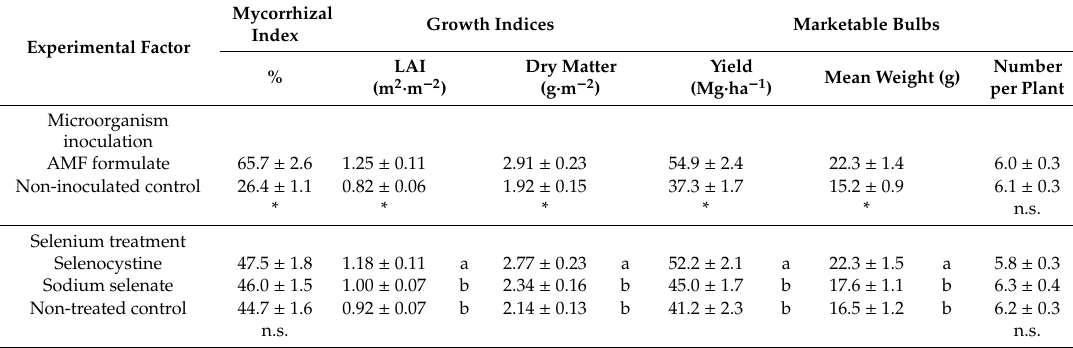
Table 1. E ff ect of microorganism inoculation and selenium treatment on shallot bulb yield.